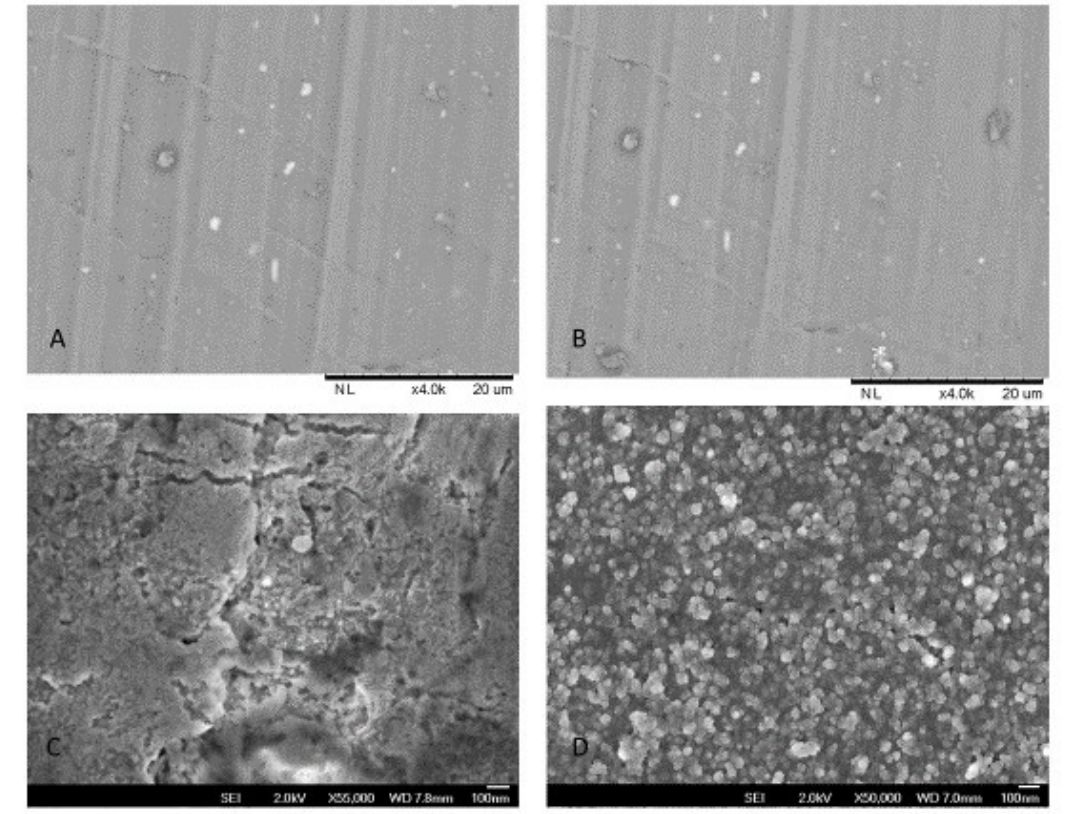
Figure 6. SEM micrographs showing (A) Control AA1230 clad on AA2024 alloy at low magnification, (B) same area after CeHT treatment, (C) Control AA1230 clad on AA2024 alloy at high magnification and, (D) CeHT treated surface at high